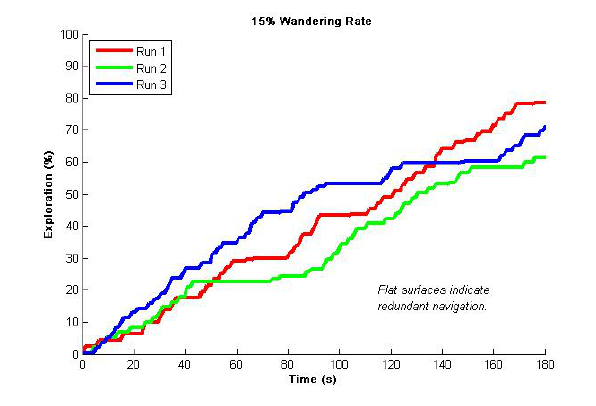
Figure 4. Single robot exploration simulation results: ( a ) 15% wandering rate and flat zones indicating high redundancy; ( b ) Better average results with less redundancy using 10% wandering rate; ( c ) 5% wandering rate shows little improvements and higher redundancy; ( d ) Avoiding the past with 10% wandering rate, resulting in over 96% completion of a 200 m 2 area exploration for every run using one